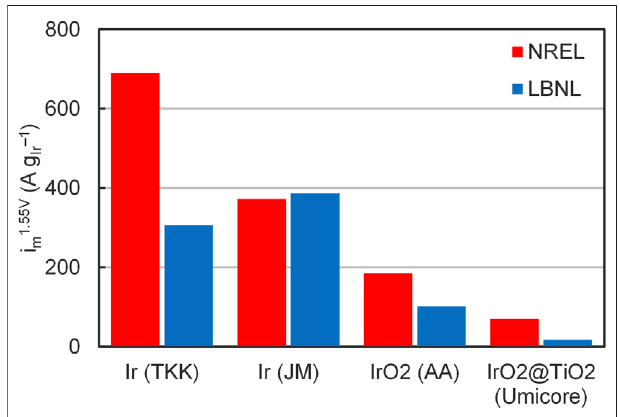
FIGURE 1 | Catalyst OER mass activities at 1.55 V for NREL (red) and LBNL (blue), comparing TKK, JM, AA, Umicore catalysts. Data adapted from (Alia et al., 2016a; Alia and Anderson,